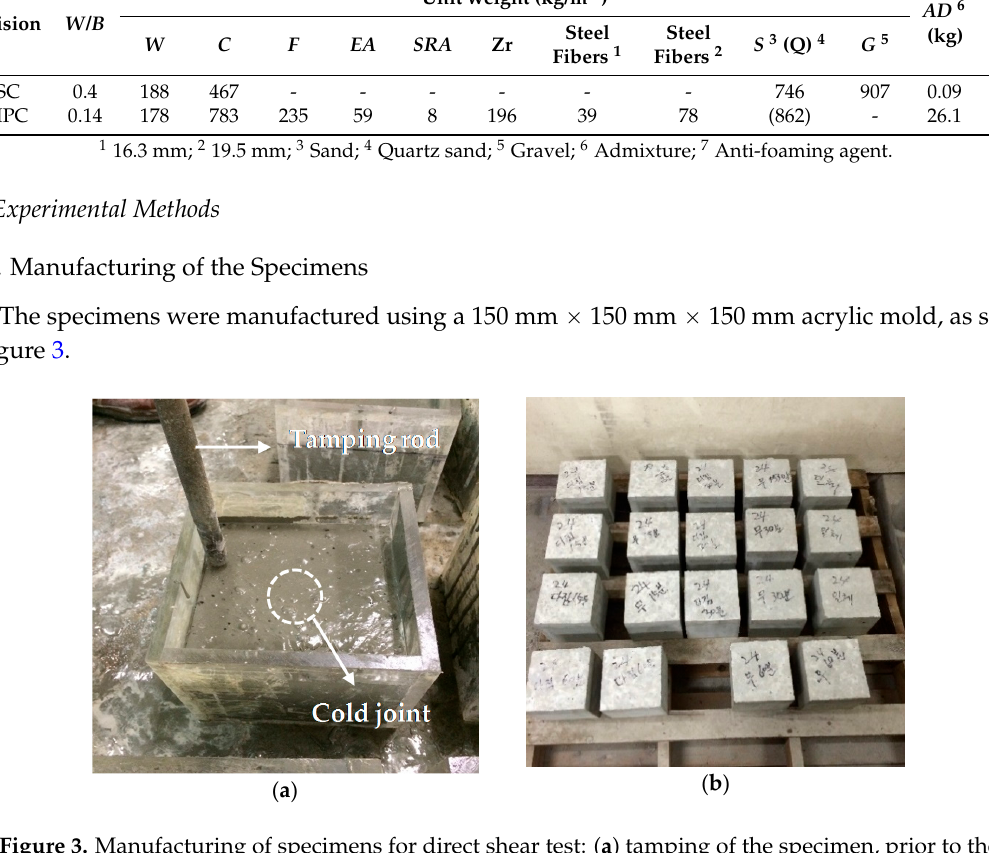
Table 6. Concrete mix proportions.